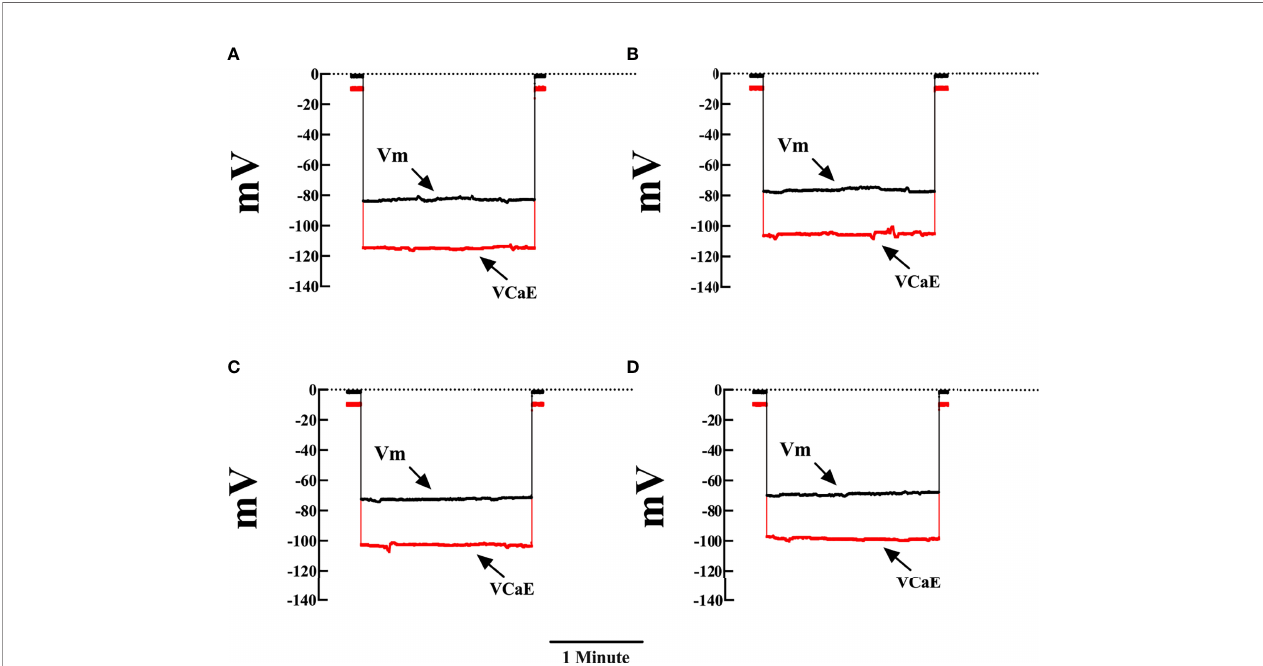
FIGURE 1 | Representative measurements of Vm and [Ca 2+ ] d in cardiomyocytes from control and Chagas infected mice. Simultaneous measurements of membrane potential (Vm) and [Ca 2+ ] d (A) Cardiomyocyte from control mice (Vm was -82 mV and [Ca 2+ ] d 122 nM). (B) Cardiomyocyte from EAP-infected mice (Vm was -76mV and [Ca 2+ ] d 200 nM). (C) Cardiomyocyte from AP-infected mice (Vm was -73 mV and [Ca 2+ ] d 312 nM). (D) Cardiomyocyte from CP-infected mice (Vm was -69 mV and [Ca 2+